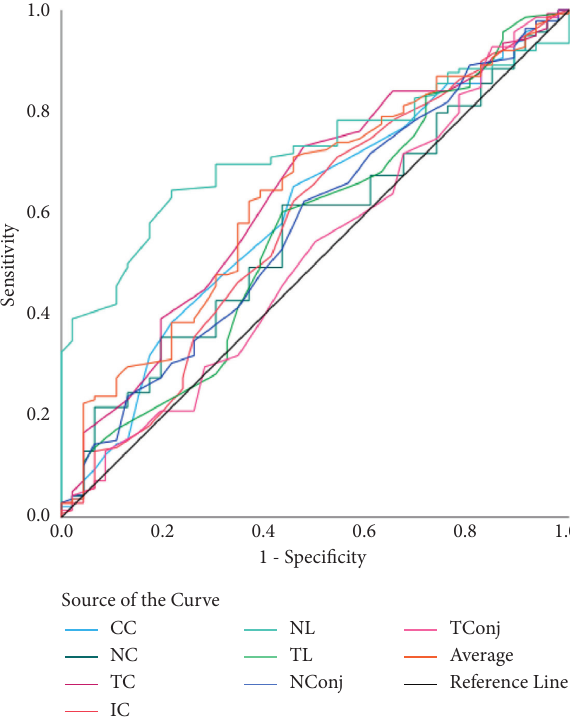
Figure 4: ROC curves of ocular surface temperature for moderate dry eye disease. ROC curves represent the moderate dry eye disease group vs. nondry eye (normal), mild dry eye, and severe dry eye